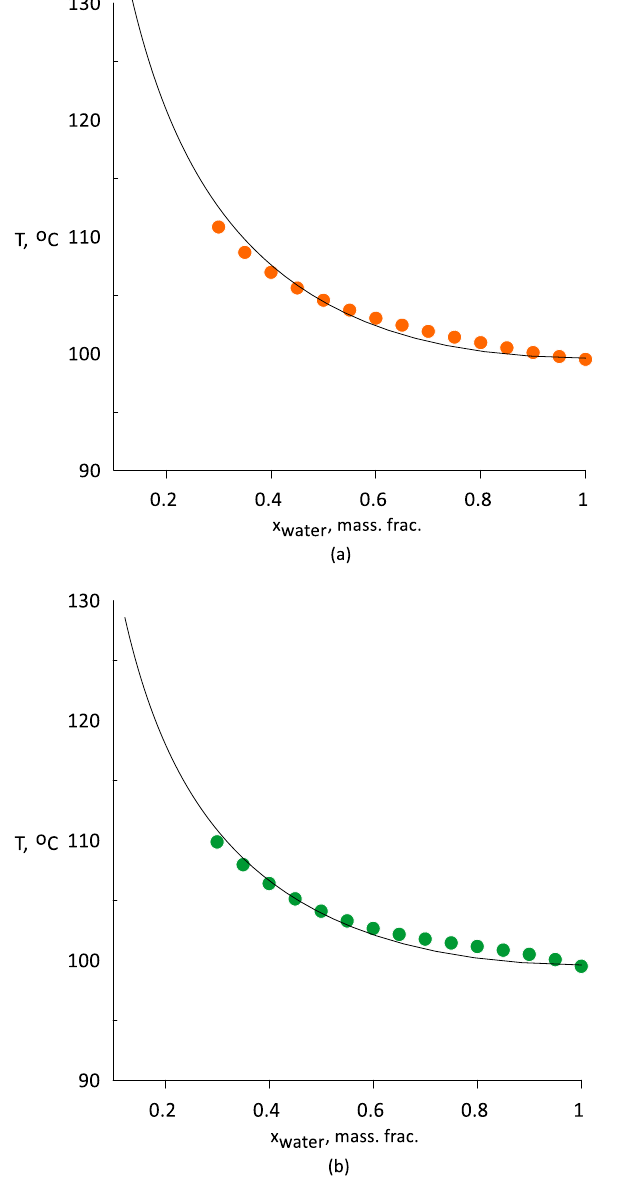
Figure 4. Boiling points of AEPA-Gl and AEPA-DEG aqueous solutions. Geometric figures are ex- perimental data (( a ) circles: AEPA-Gl, ( b ) squares: AEPA-DEG ) and lines are calculated data. experimental data (( a ) circles: AEPA-Gl, ( b ) squares: AEPA-DEG) and lines are calculated